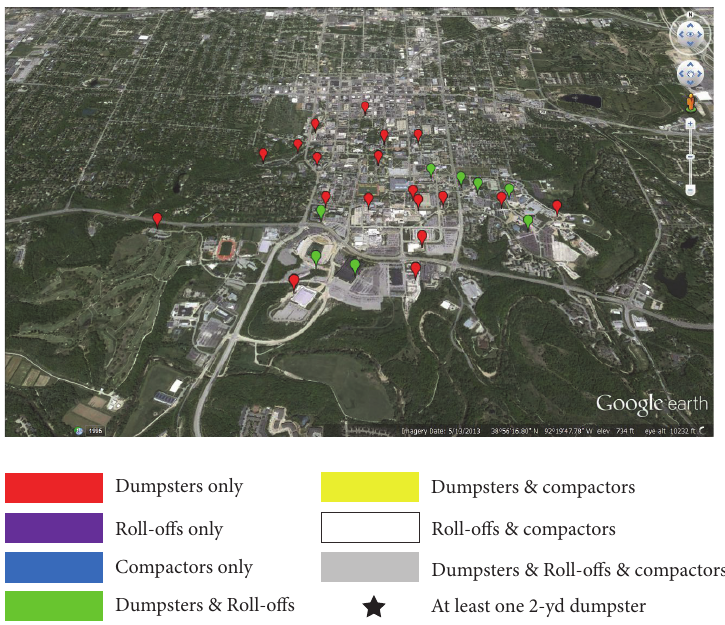
Figure 5: Distribution of receptacles around MU campus, highly robust ( 𝜂 = 100 )